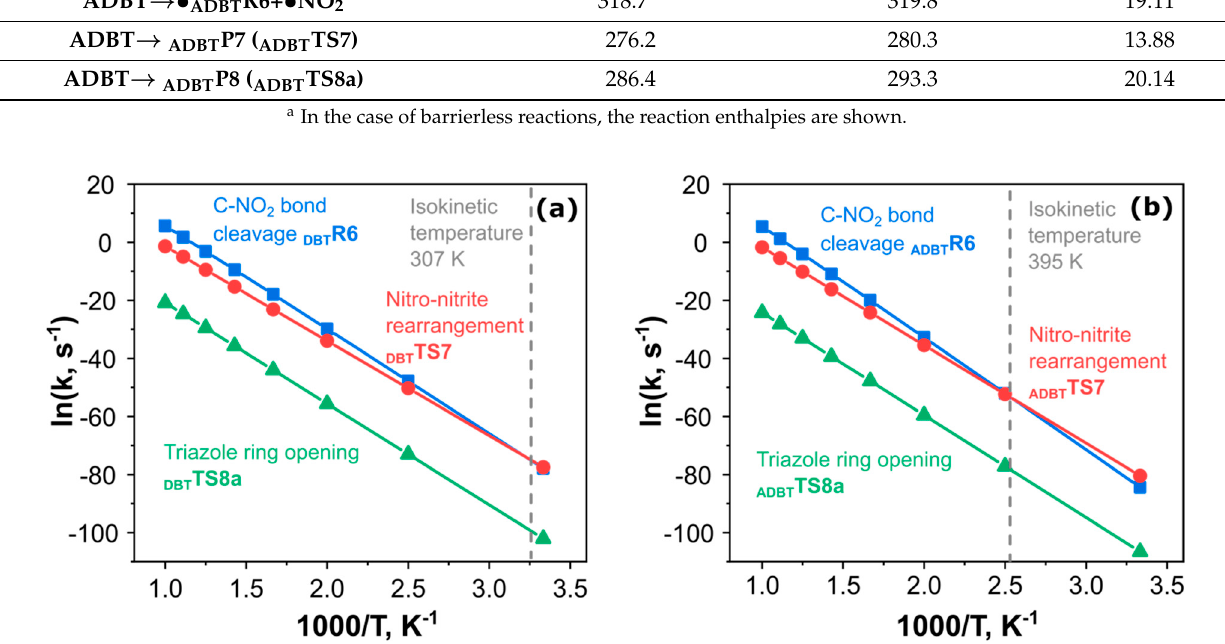
Figure 10. The Arrhenius plots for competitive reactions in the initial decomposition mechanisms for DBT ( a ) and ADBT ( b ): xR6 –the C-NO 2 radical cleavage bond (blue lines), x TS7 –the nitro-nitrite isomerization (red lines), and xTS8 –the triazole ring opening (green lines).